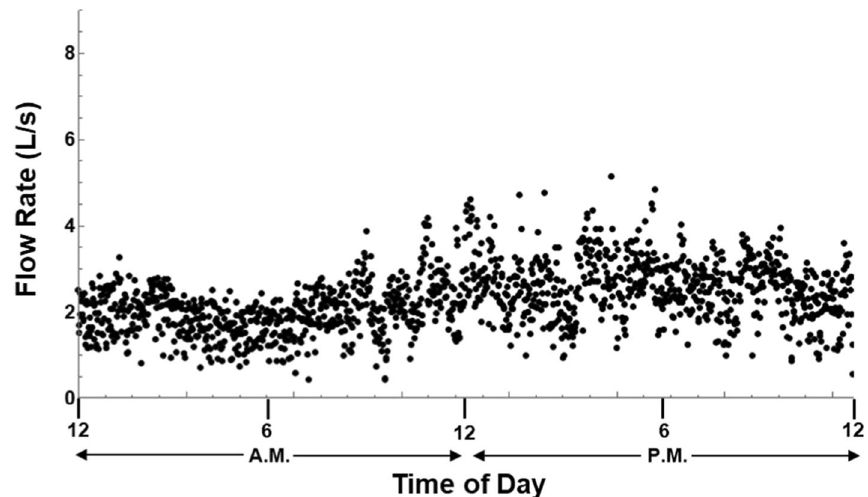
Fig. 13 Friday average readings for daily flow